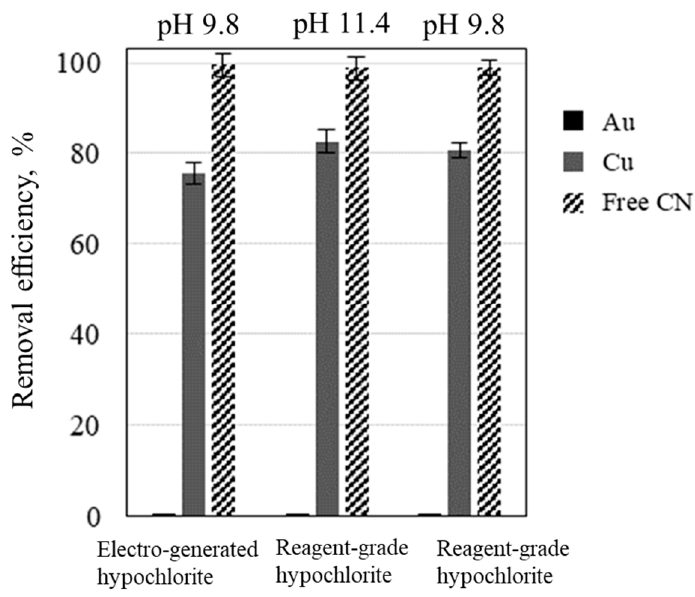
Figure 2. Removal efficiency of Cu, Au, and free cyanide with electro-generated NaOCl and reagent-grade NaOCl (initial pH, 9.8, 11.4; temperature, 298 K; time, 12 h without agitation; total volume, 200 mL with NaOCl / leach solution ratio 1; electro-generated and reagent-grade NaOCl chlorine concentration 5.2 g / L).